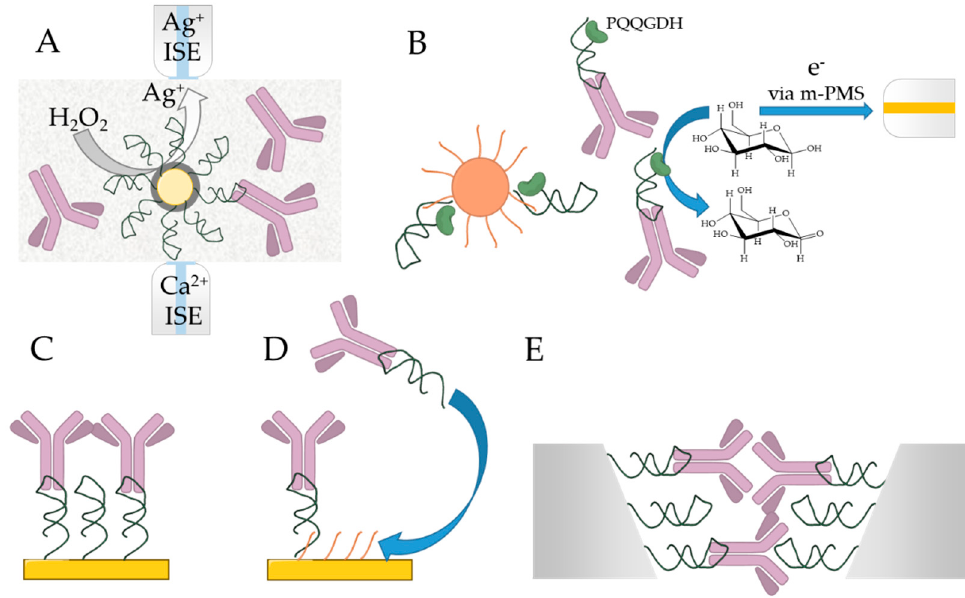
Figure 9. Potentiometric ( A ) [142]; amperometric ( B ) [143]; array-based impedimetric ( C , D ) [146,147];